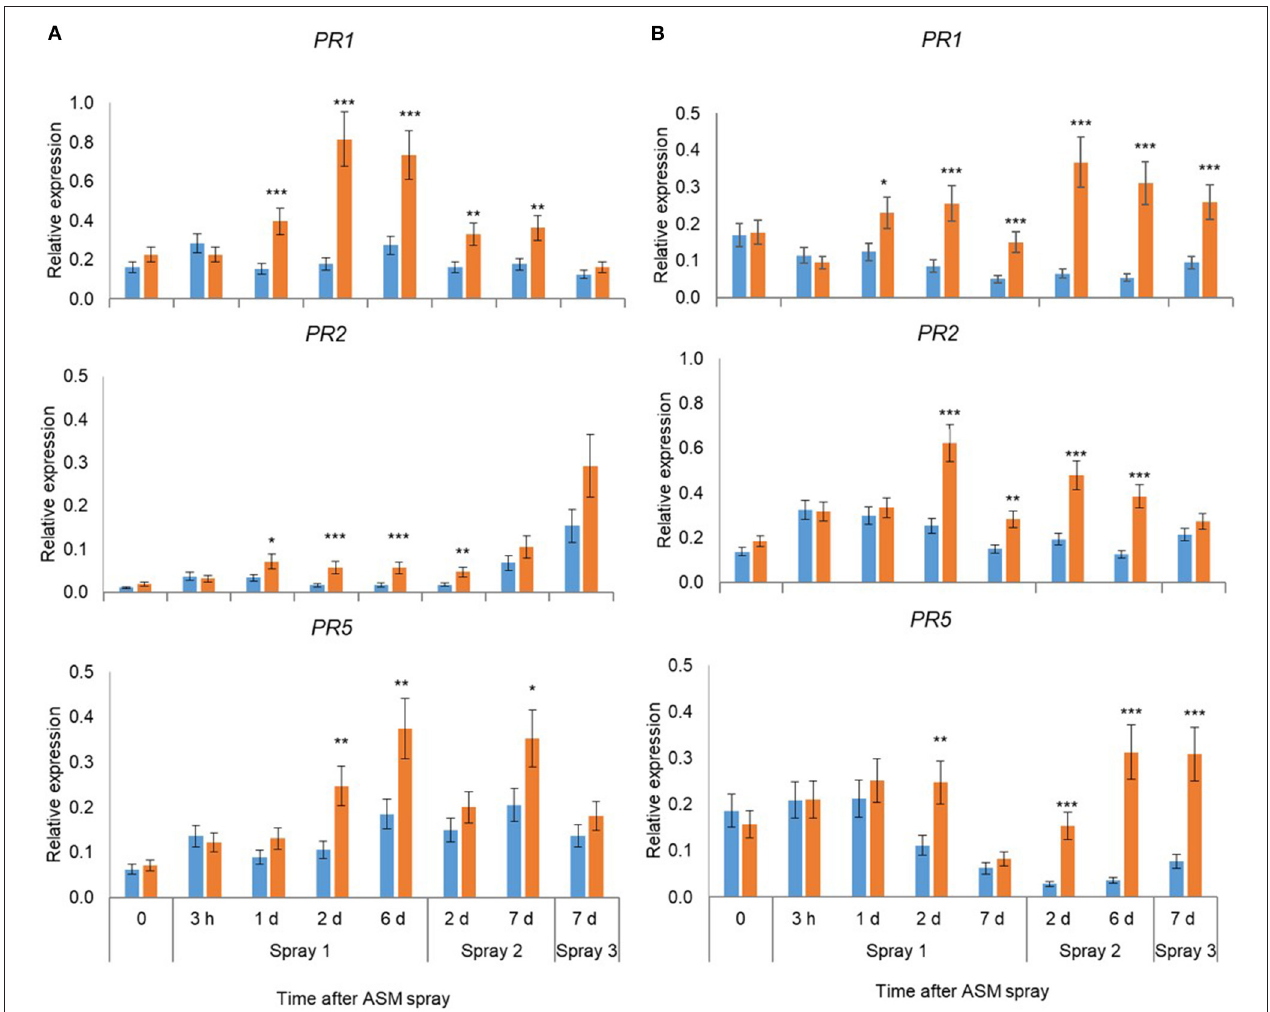
FIGURE 2 | Expression of PR1, PR2, and PR5 in leaves of Actinidia chinensis var. deliciosa ‘Hayward’ (A) and A. chinensis var. chinensis ‘Zesy002’ vines (B) at different times after Actigard (ASM) application during spring in 2016. Actigard (ASM) was sprayed on ‘Zesy002’ on 18 October, 26 October, and 1 November, and on ‘Hayward’ on 26 October, 1 November, and 9 November. Gene expression was quantified by qPCR using actin and ubiquitin-conjugating enzyme as the reference genes for ‘Hayward,’ and 40S rRNA and GAPDH as the reference genes for ‘Zesy002.’ Data were log 2 transformed for analysis, but are presented as back-transformed means. Asterisks above bars indicate significant treatment differences, where * < 0.05, ** < 0.01, and *** <